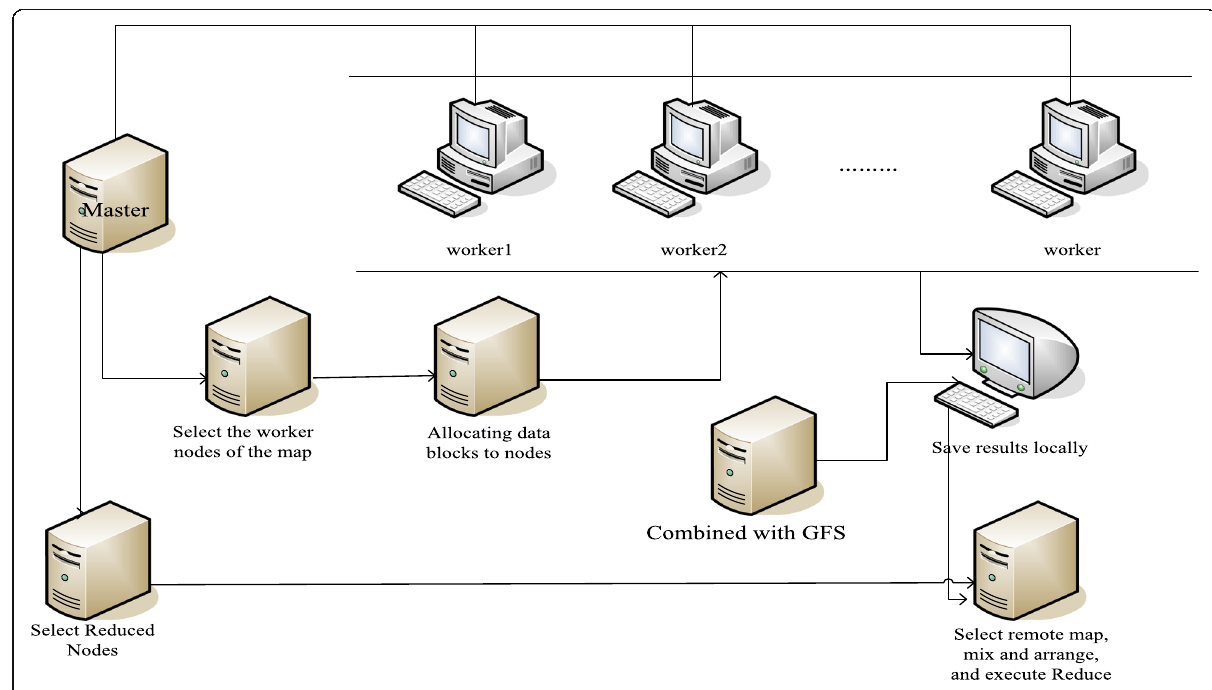
Fig. 3 Parallel execution of cloud